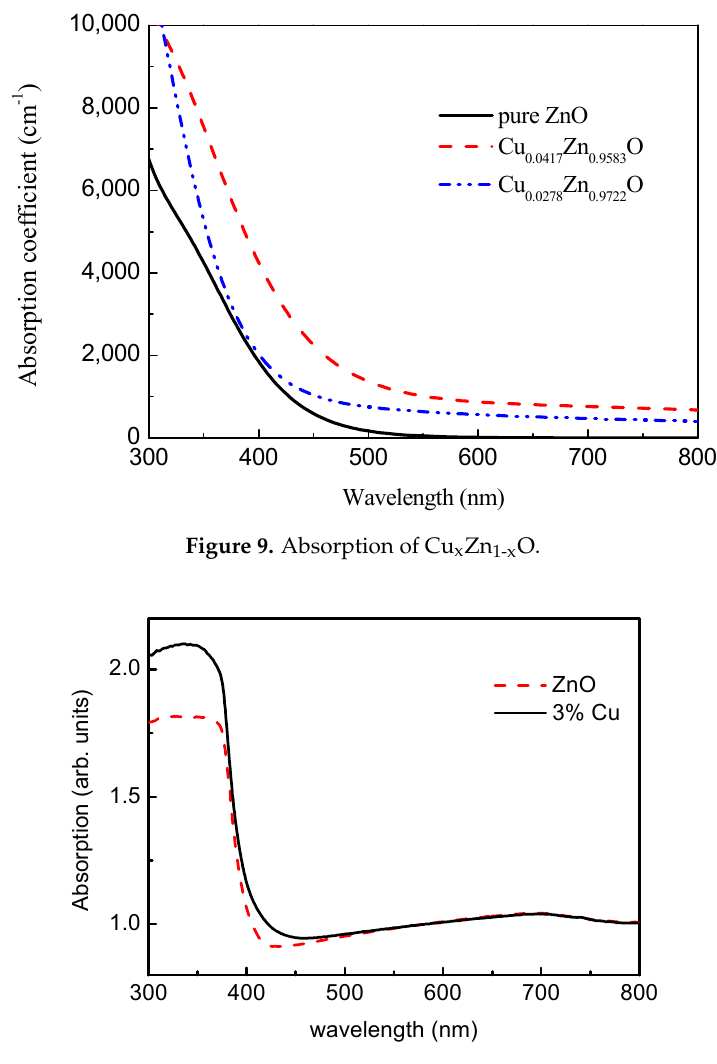
Figure 10. Absorption of pure ZnO and Cu doped ZnO.